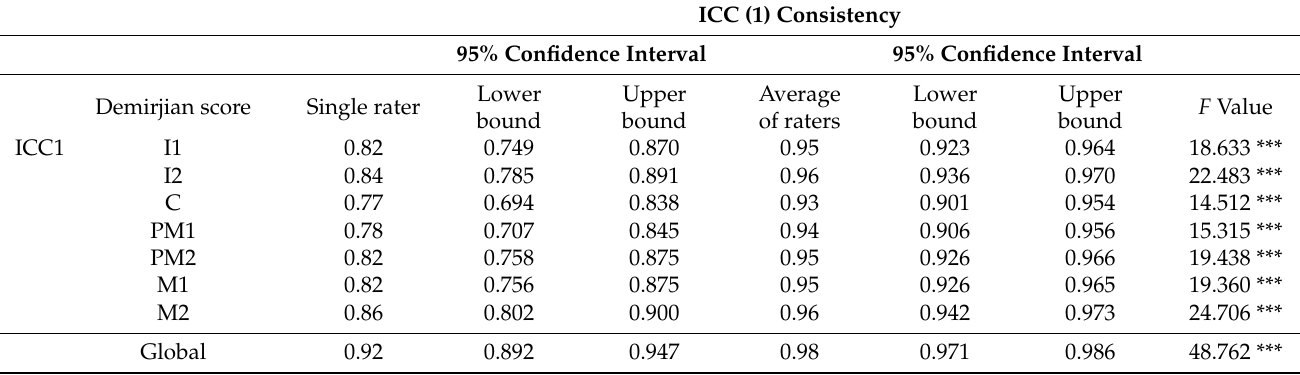
Table 1. Inter-rater